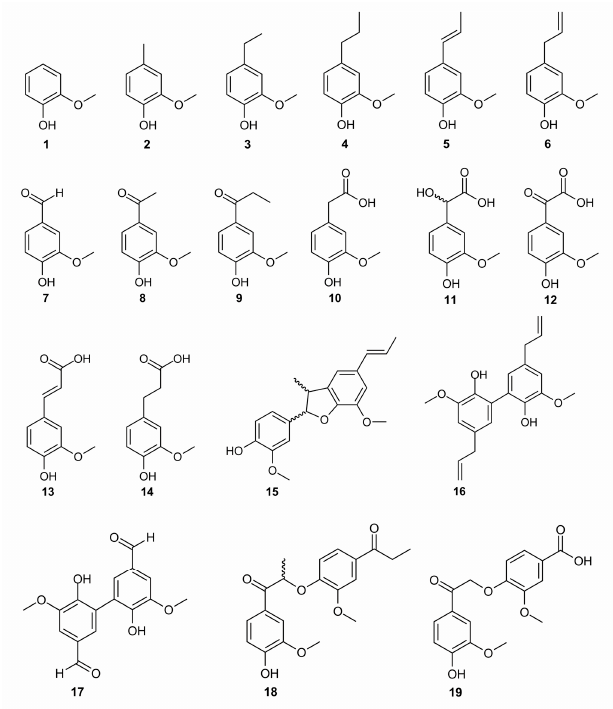
Figure 1. Chemical structures of the lignin model compounds.